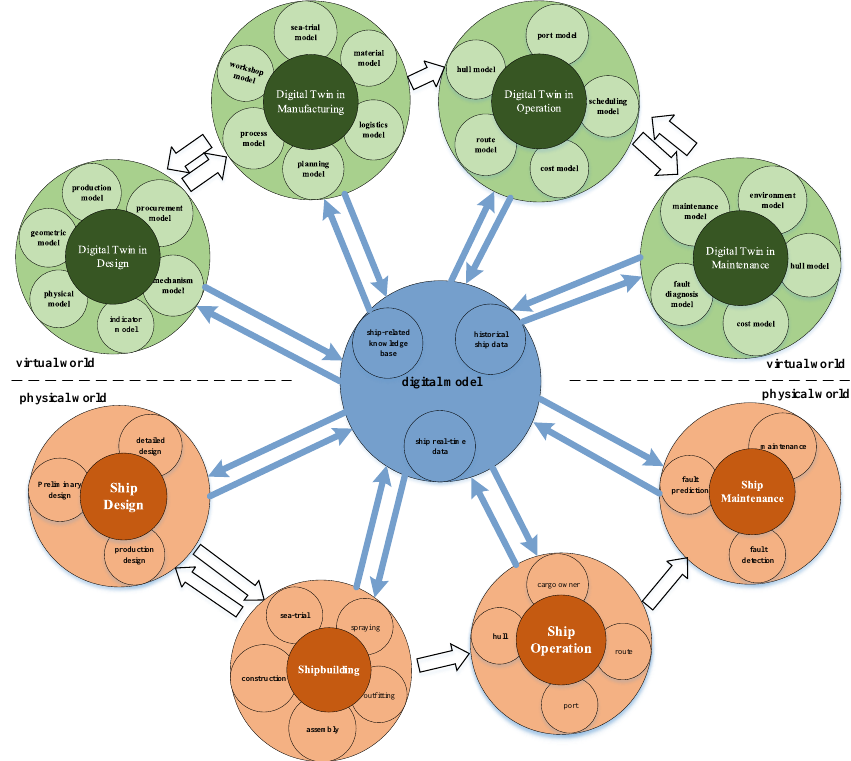
Figure 5. The operation mechanism of ship digital